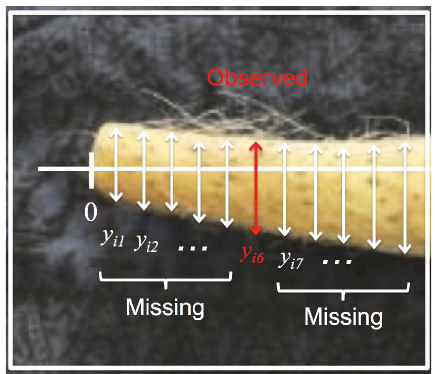
, . . . ). All missing diameters 𝑖6